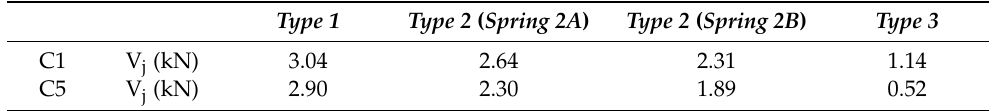
Table 8. Maximum stresses in the joints derived from the load test for models C1 (without slip) and C5 (with